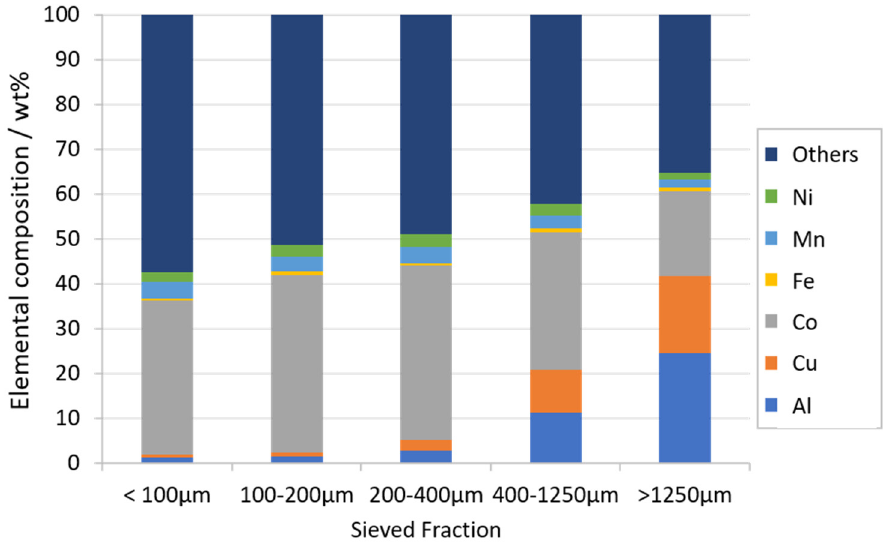
Figure 4. The elemental compositions of the sieved waste LIB feed.